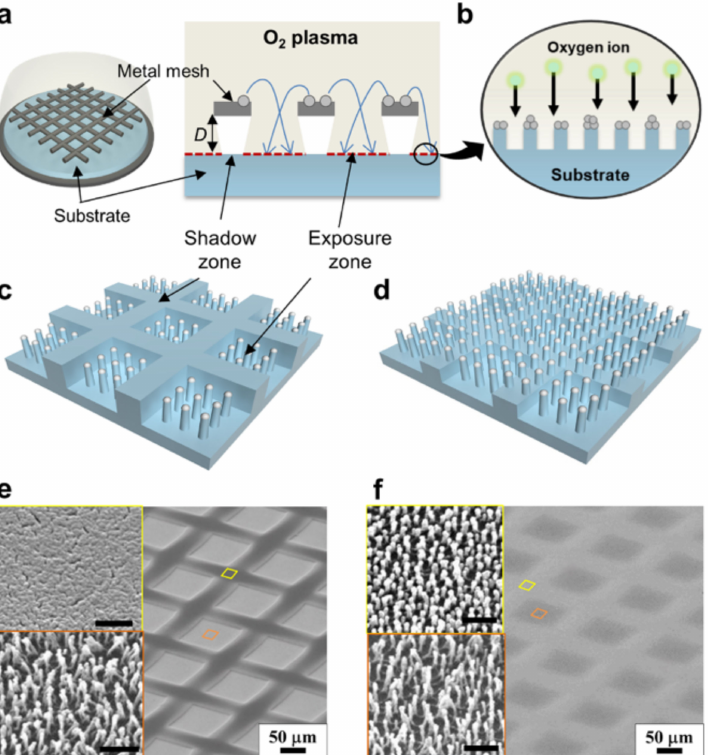
Figure 16. Schematic illustration of hybrid patterning process using dual scale metallic mesh; ( a ) shadow zone with microscale structures, ( b ) nanoscale etching mask, ( c , e ) hybrid textures includ- ing micro walls and nanostructures, and ( d , f ) hierarchical pillars consisting of low micro walls and nanostructures with shorter gap distances. Scale bars in insets are 500 nm